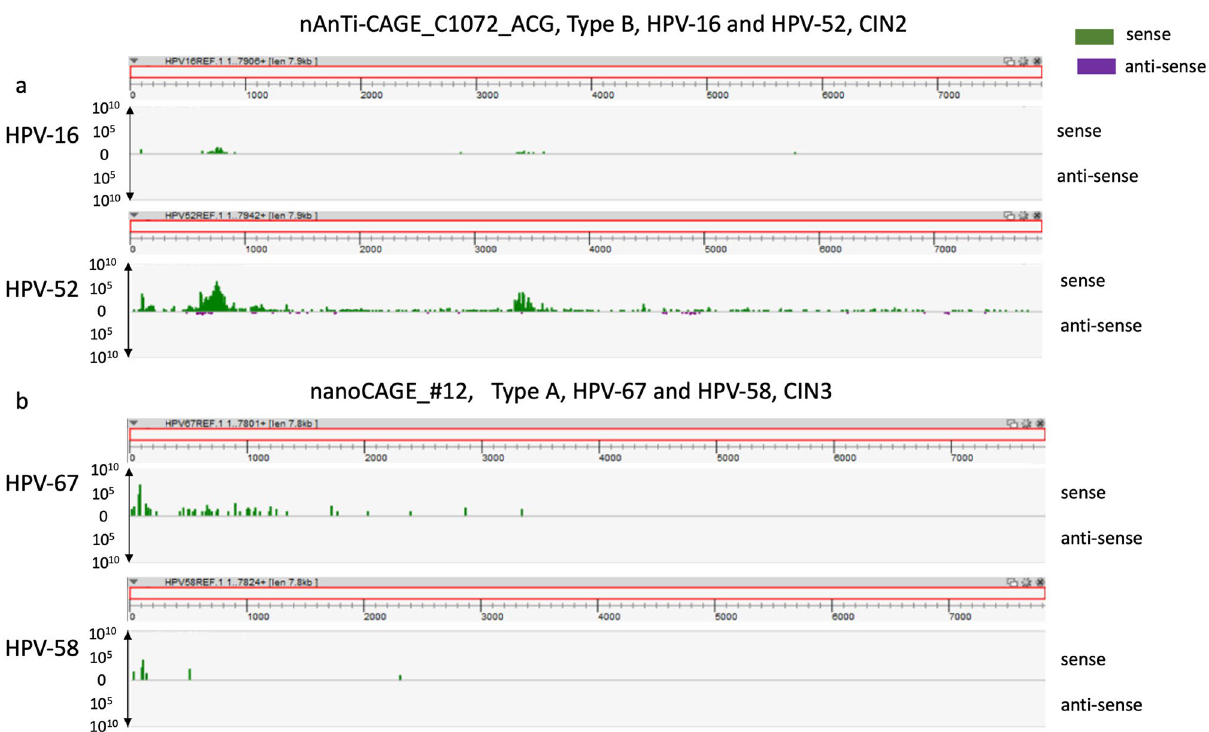
Figure 4. TSS patterns of cervical lesions with HPV co-infection. ( a ) nAnTi-CAGE analysis of a CIN sample co-infected with HPV-16 and HPV-52. To visualise TSS activity at a single-nucleotide level, nAnTi-CAGE data were visualised using ZENBU software. ( b ) nanoCAGE analysis of a CIN sample co-infected with HPV-67 and HPV-58. To visualise TSS activity at a single-nucleotide level, nanoCAGE data were visualised using ZENBU software. HPV human papillomavirus; TSS transcription start site; CIN cervical intraepithelial